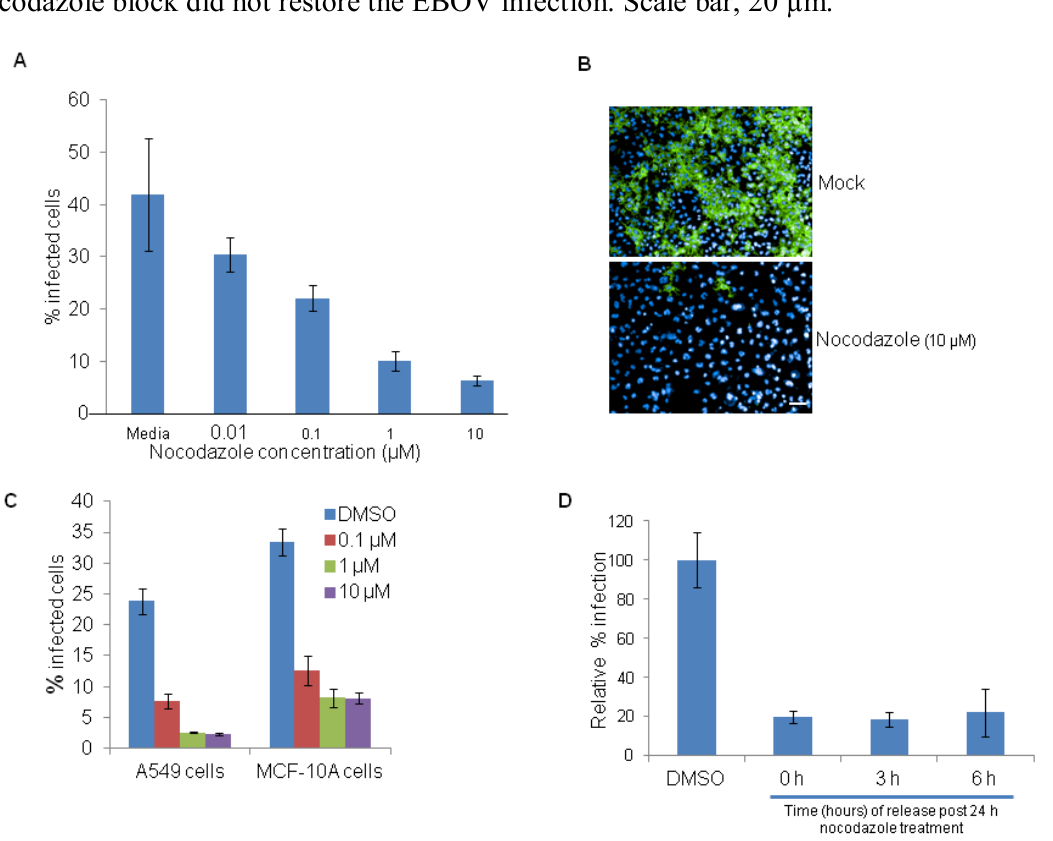
Figure 4. Nocodazole restricts EBOV infection. ( A ) HeLa cells were pretreated for 12 h with DMSO control or with indicated concentrations of nocodazole, and then infected with 5 MOI of EBOV for 24 h in the absence of the inhibitor. A dose dependent decrease in virus infection was observed. ( B ) Representative images of HeLa cells infected with EBOV and stained with anti-GP antibody (6D8) (green) and nuclear Hoechst dye (blue), following pretreatment with DMSO (top panel) or nocodazole (10 µM, bottom panel). ( C ) A549 or MCF-10A cells were pretreated with DMSO control or with 0.1, 1 or 10 µM nocodazole and then infected with 5 MOI of EBOV for 24 h in the absence of the inhibitor. Both A549 and MCF-10A cells showed reduced infection with increasing concentrations of nocodazole. ( D ) HeLa cells were released from nocodazole block and at time points of 0, 3 and 6 h, post release were infected for 24 h with 5 MOI of EBOV. Removal of nocodazole block did not restore the EBOV infection. Scale bar, 20